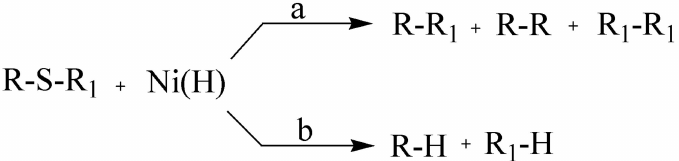
Figure 4. Desulfurization method under Mozingo conditions ( a ) and in the presence of su ffi cient Raney nickel catalyst ( b